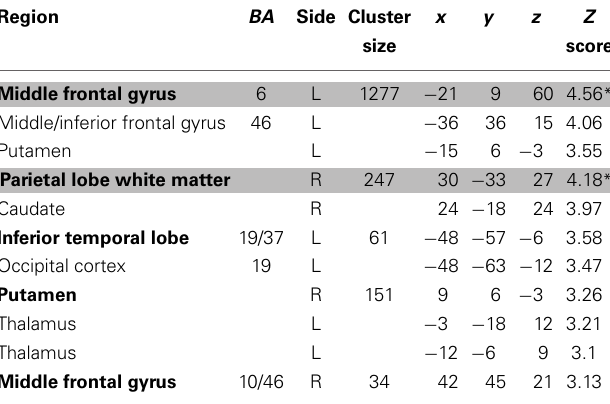
Table 3 | Regions reflecting discounted stimulus value at the time of choice in